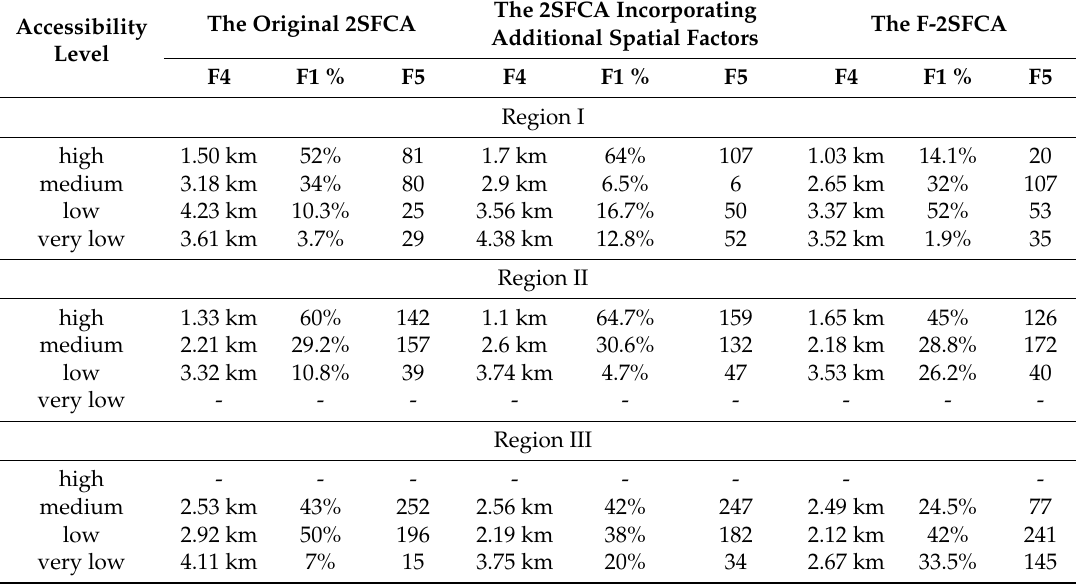
Table 3. The parameters describing fire service difference changes calculated by different methods in three pre-defined